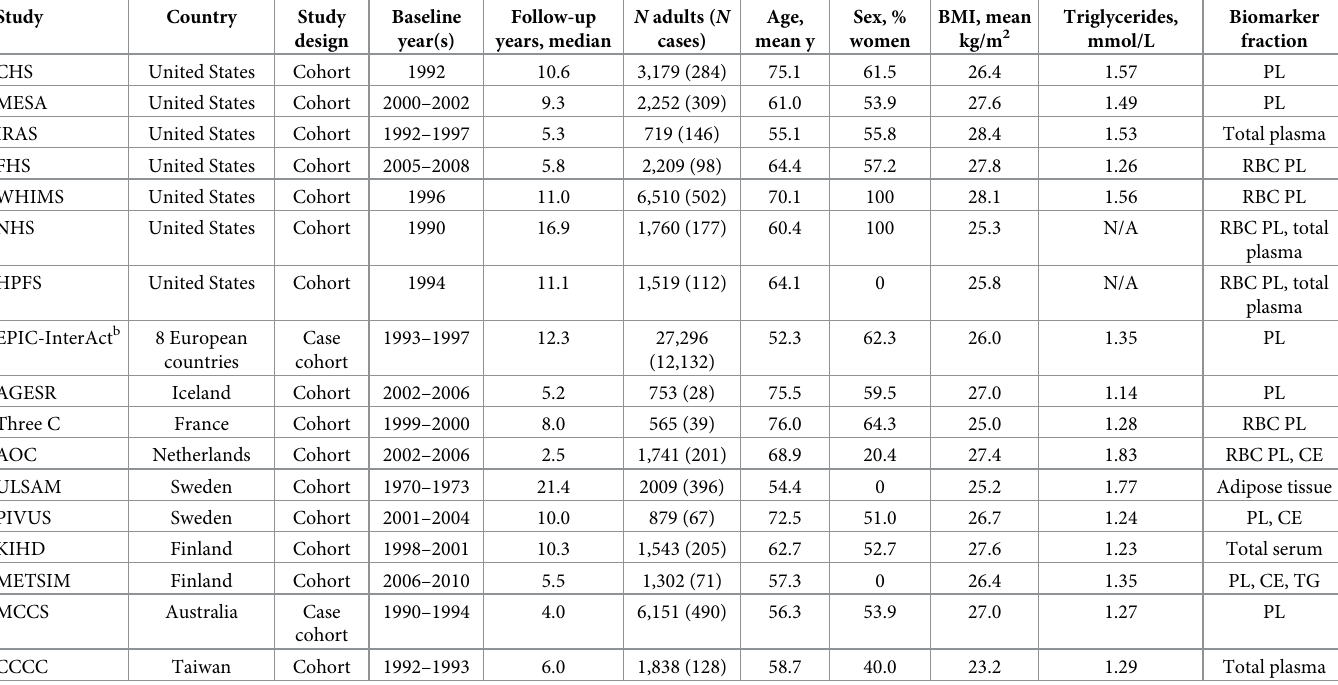
Table 1. Baseline characteristics of 17 studies of the pooling analysis of fatty acids on DNL pathway and incident T2D: FORCE a